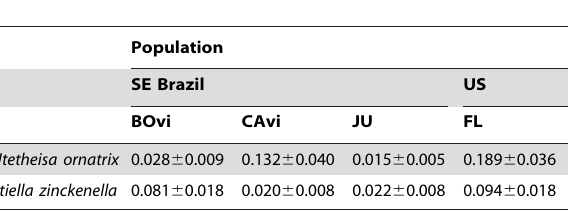
Table 2. Field differences among populations in the proportion of pods attacked per plant by Utetheisa ornatrix and Etiella zinckenella